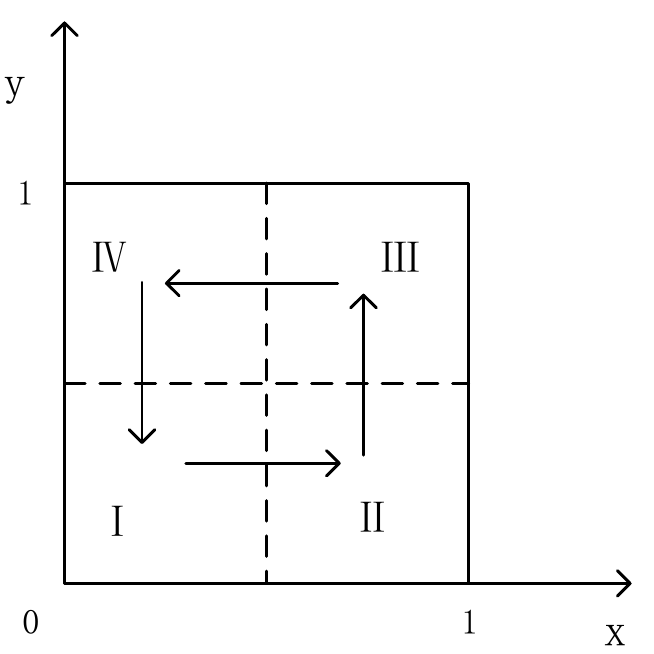
Figure 2. Evolution phase diagram of game system. (F2.I: When the initial state falls in region I, the stabilization strategy of the evolutionary game is (positive supervision, non-green construction); F2. II: When the initial state falls in region II, the stabilization strategy of the evolutionary game is (passive supervision, non-green construction); F2. III: When the initial state falls in region III, the stabilization strategy of the evolutionary game is (passive supervision, green construction); F2. IV When the initial state falls in region IV, the stabilization strategy of the evolutionary game is (positive supervision, green construction)).